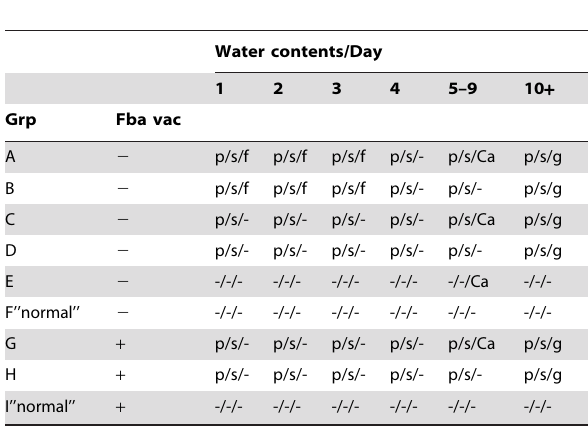
Table 2. Experiment leading to preliminary indications of horizontal transmission of Candida